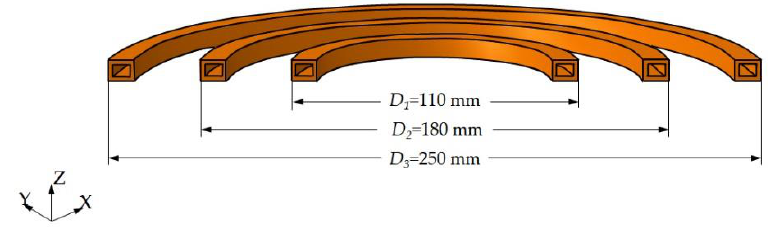
Figure 14. Schematic diagram of sizes of multiple coils.